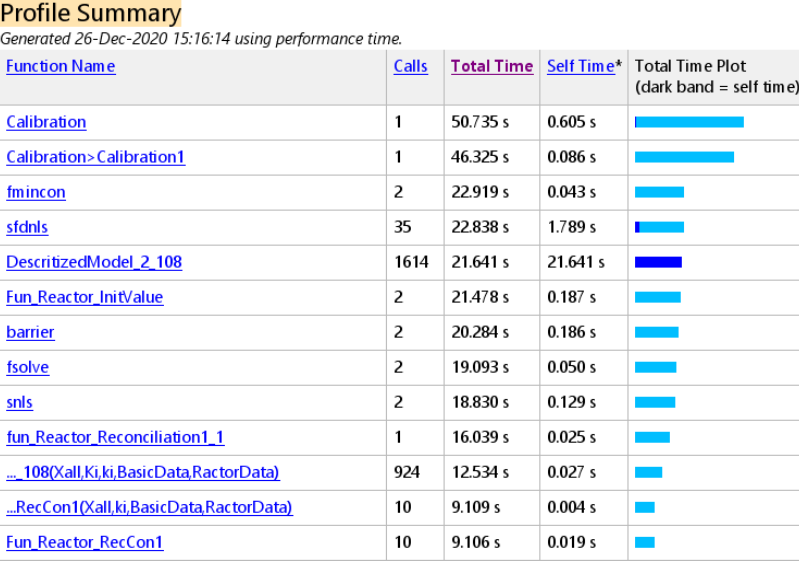
Figure 4. The time taken by some procedures using the simultaneous equations